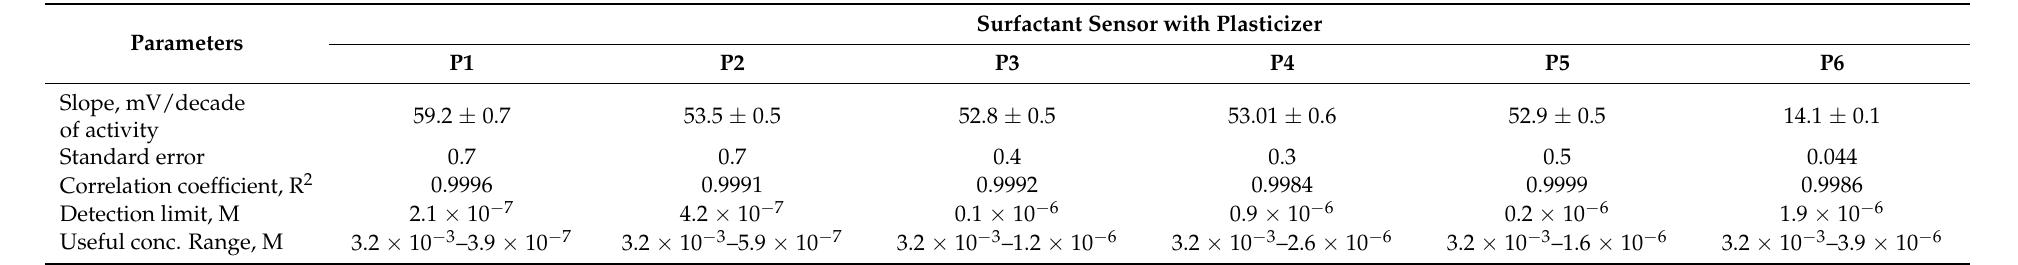
Table 4. Statistics of the response characteristics of the P1–P6 surfactant sensors on CTAB, given together with ± 95% confidence limits.